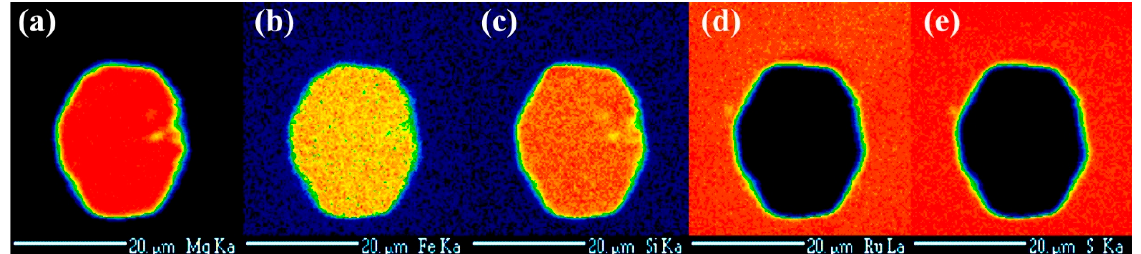
Figure 5. X-ray maps of high-Mg olivine inclusion in laurite (sample 164). ( a )—MgK α , ( b )—FeK α , ( c )—SiK α , ( d )—RuL α , ( e )—SK α .